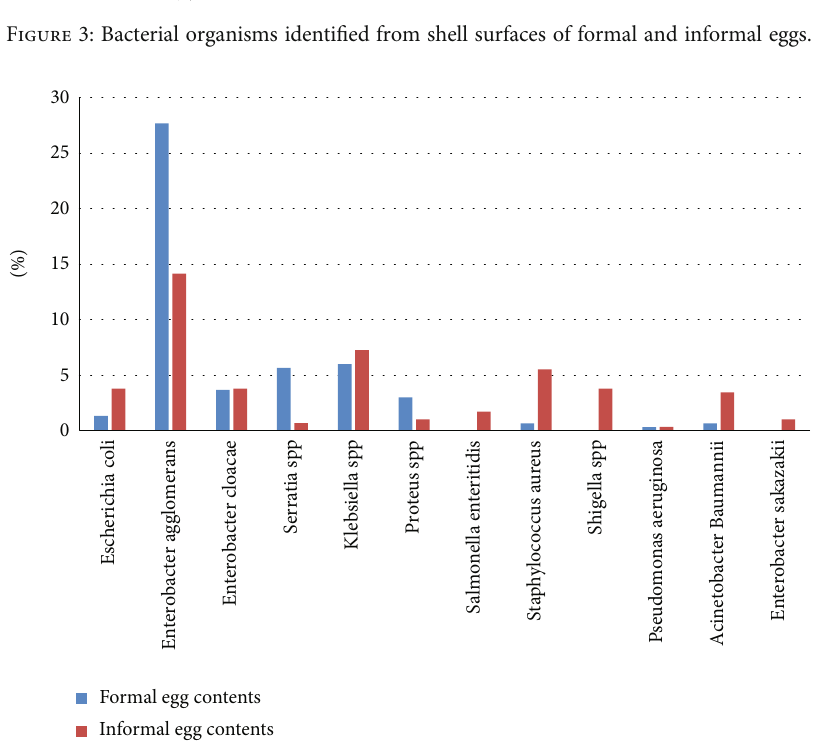
Figure 4: Bacterial organisms isolated from contents of formal and informal